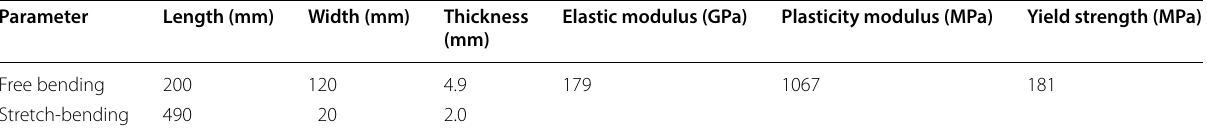
Table 1 Geometrical dimensions and material properties of A283‑D steel sheet